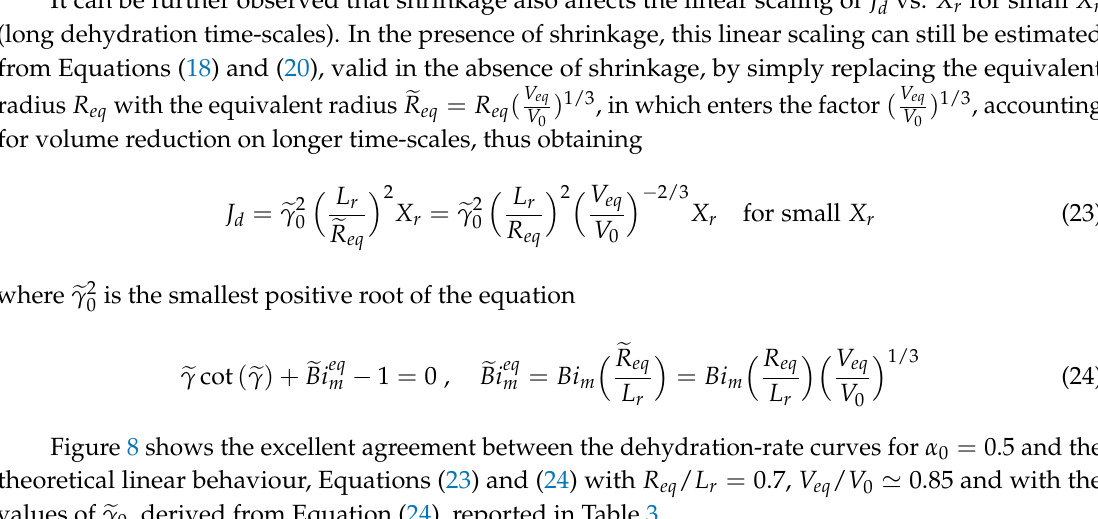
Figure 7. Dimensionless dehydration rate J d vs. moisture ratio X r = ( X − X eq ) / ( X 0 − X eq ) for Bi m = 1,3,5,9 and for a uniform initial water distribution, β core no-shrinkage. dashed lines: shrinkage factor α ( φ ) = α 0 = 0.1,0.3,0.5. Arrows indicate increasing values of α 0 .